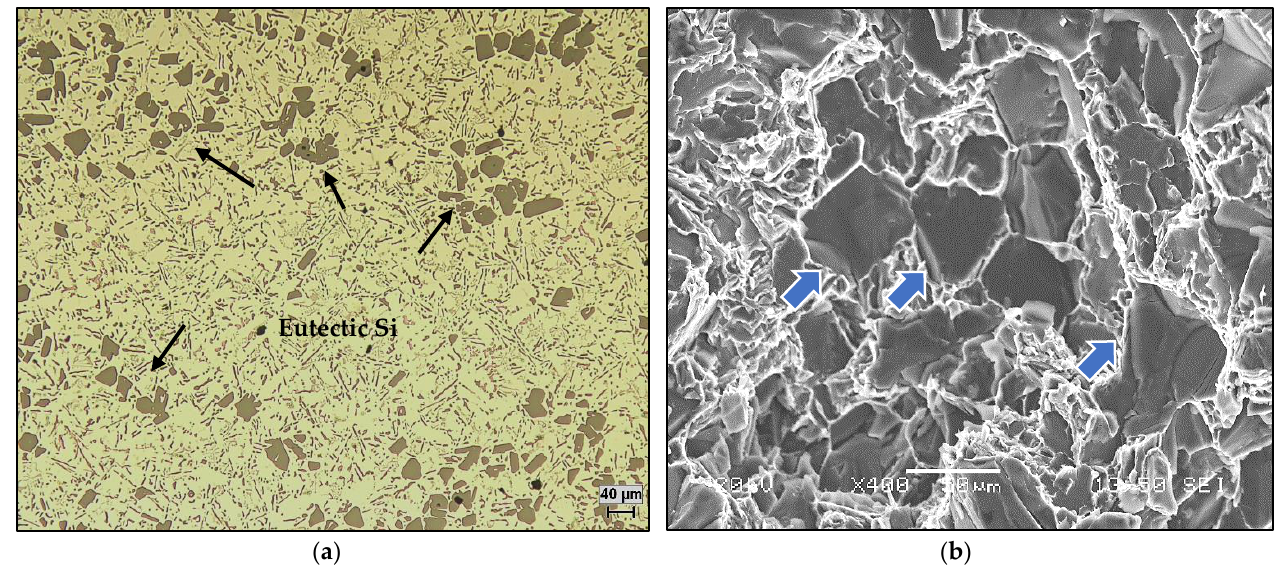
Figure 17. ( a ) Optical microstructure of the A390.1 alloy solidified at 0.8 °C/s, ( b ) fracture surface of same alloy solidified at 8 °C/s. Black and blue arrows in ( a ) and ( b ), respectively, point to the primary Si particles.